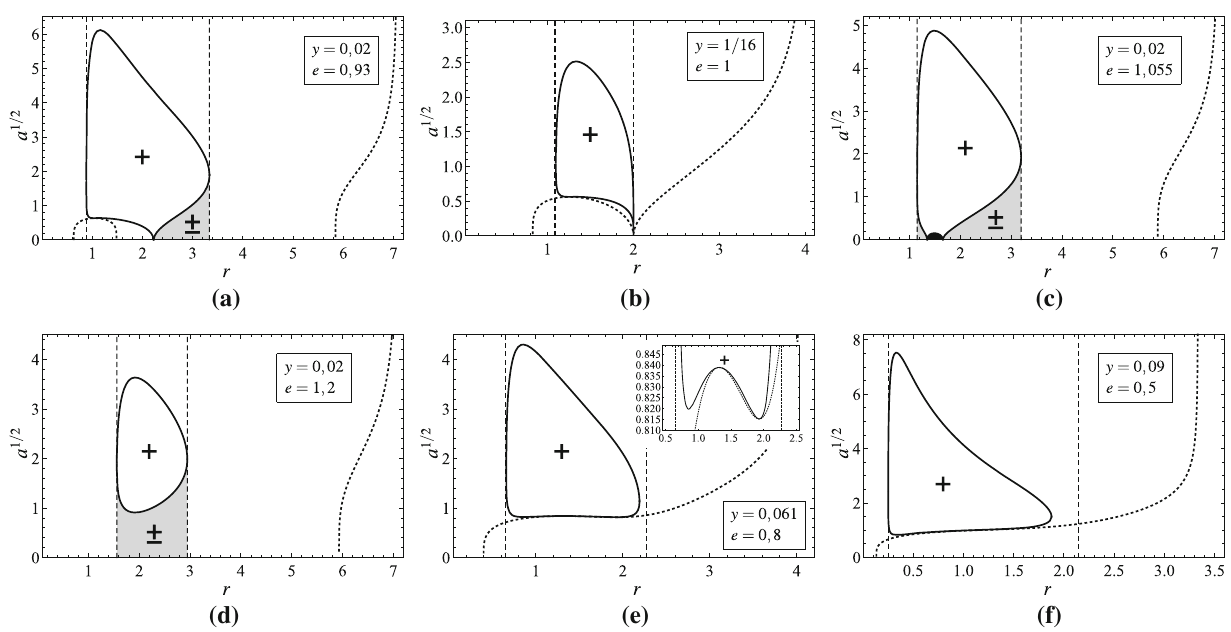
given KNdS spacetimes, respectively. Minus-family orbits exist only in the shaded regions ( a , c , d ). In the black region ( c ), there are no circular